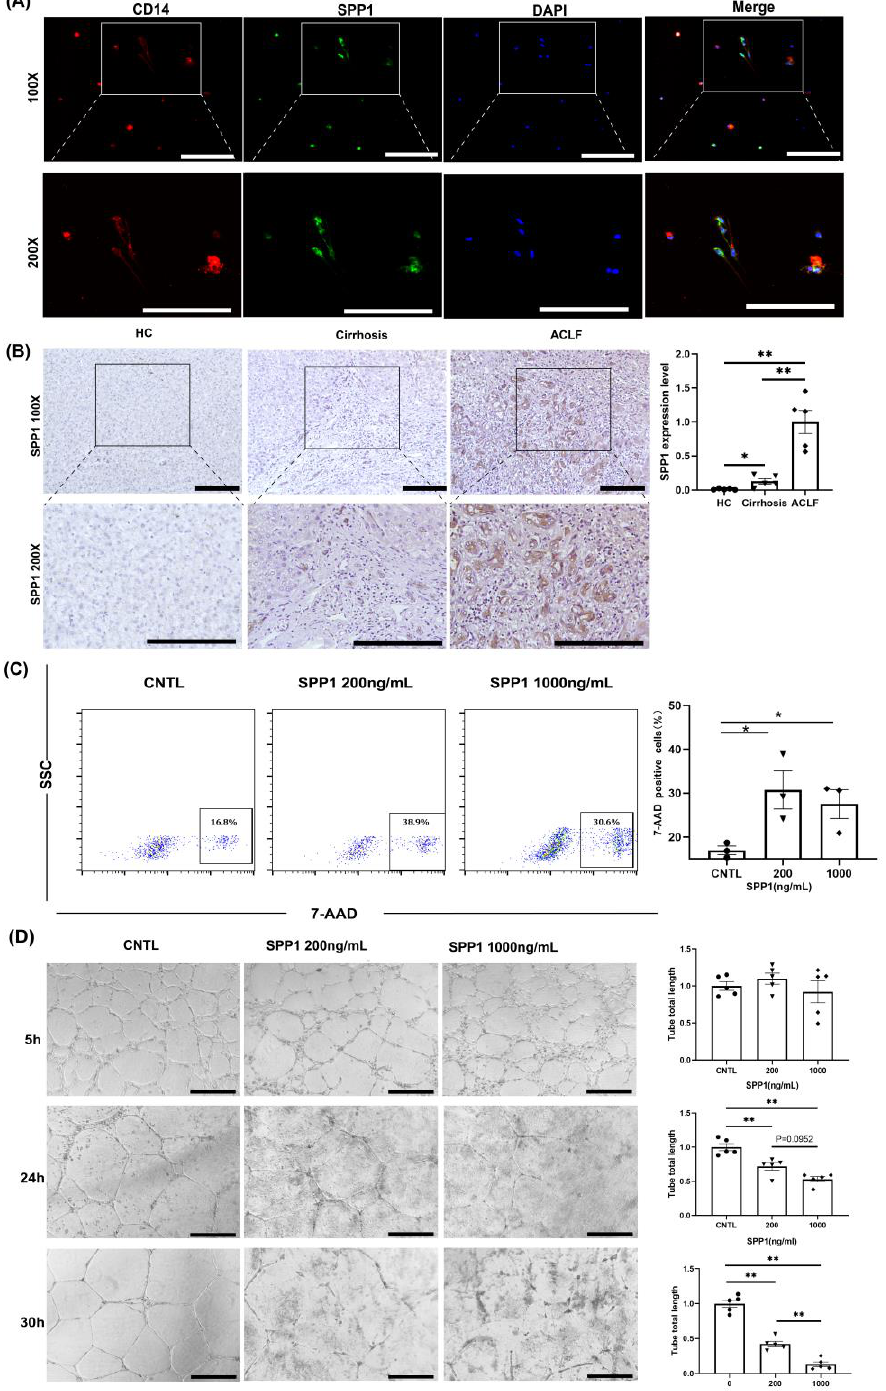
more SPP1 secreted.